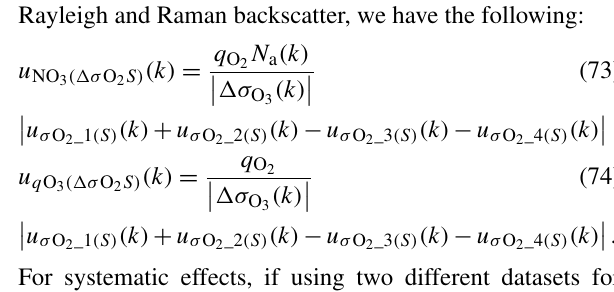
Figure 10. Ozone mixing ratio uncertainty as a function of SO 2 cross section relative uncertainty (%), assuming that all cross sec- tions used have the same relative uncertainty. Solid curves are used for cases of independent (random) cross section datasets, and dashed curves are used for the case of full correlation between all cross